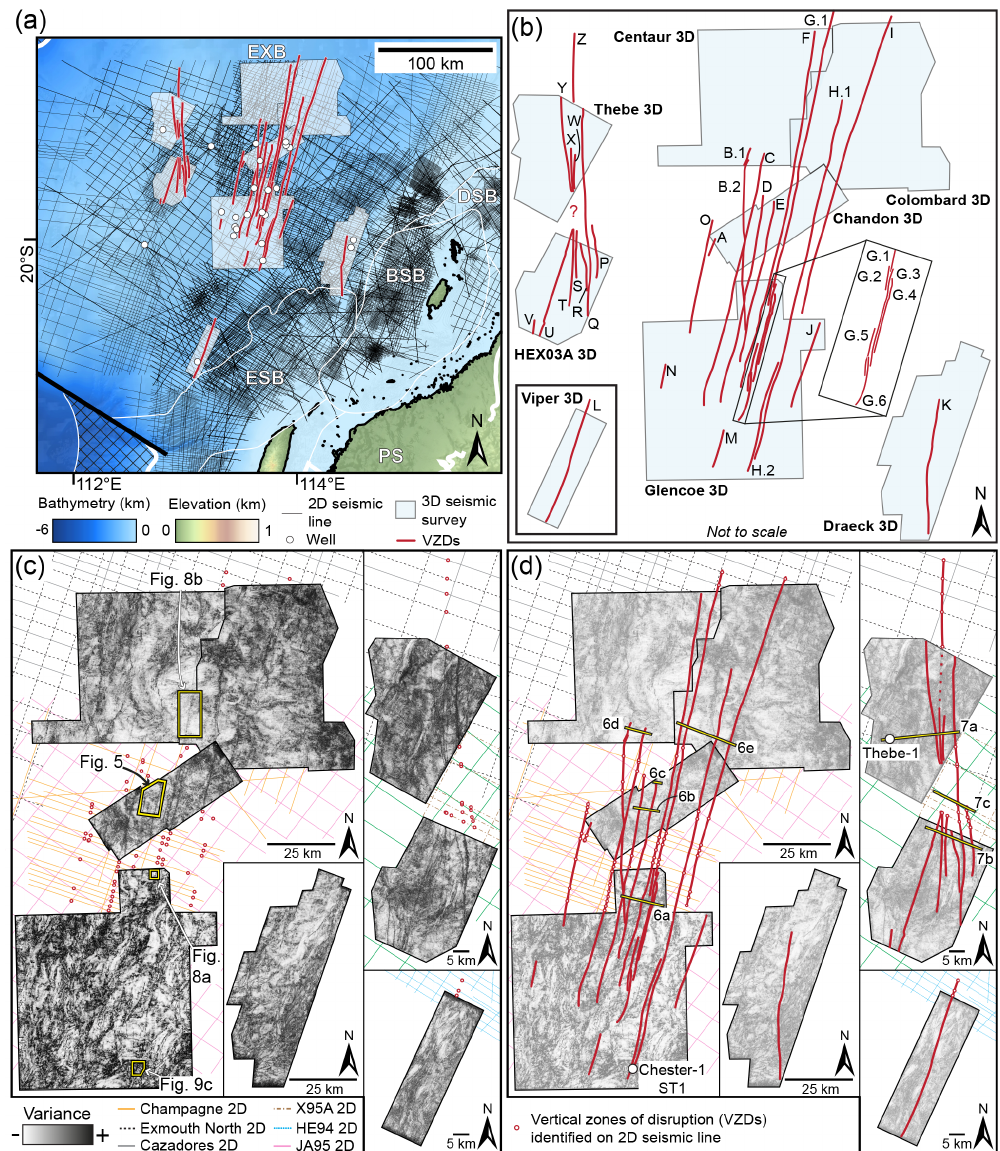
Figure 4. (a) Location map showing the 2D and 3D seismic surveys and 24 wells used in the study, as well as the plan-view configuration of the 26 vertical zones of disturbance (VZDs). See Fig. S2 for a map showing well names. (b) Zoomed-in schematic view of the mapped VZDs and the eight 3D seismic reflection surveys used. (c–d) Uninterpreted and interpreted variance time slices showing that the VZDs correspond to subtle, long, linear features; time slices shown are at 4.5s TWT (two-way travel time) for the Chandon, Glencoe, Centaur, Colombard, Draeck, and Viper 3D surveys but at 3.5s TWT for the Thebe and HEX03A surveys. The nine 2D seismic reflection surveys containing observed VZDs and used to tie VZD traces between 3D surveys are also shown. Yellow bars in (d) highlight section locations shown in Figs. 6 and